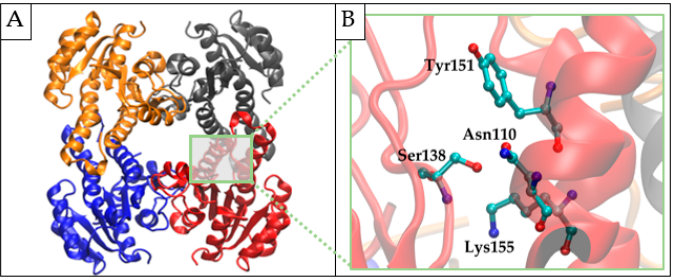
Figure 17. ( A ) Ec FabG apo tetramer structure (PDB ID 1I01). The FabG monomers are coloured in blue, red, grey and orange. ( B )View of the active site of Ec FabG (PDB ID 1I01). This view is focused on the four catalytic residues.